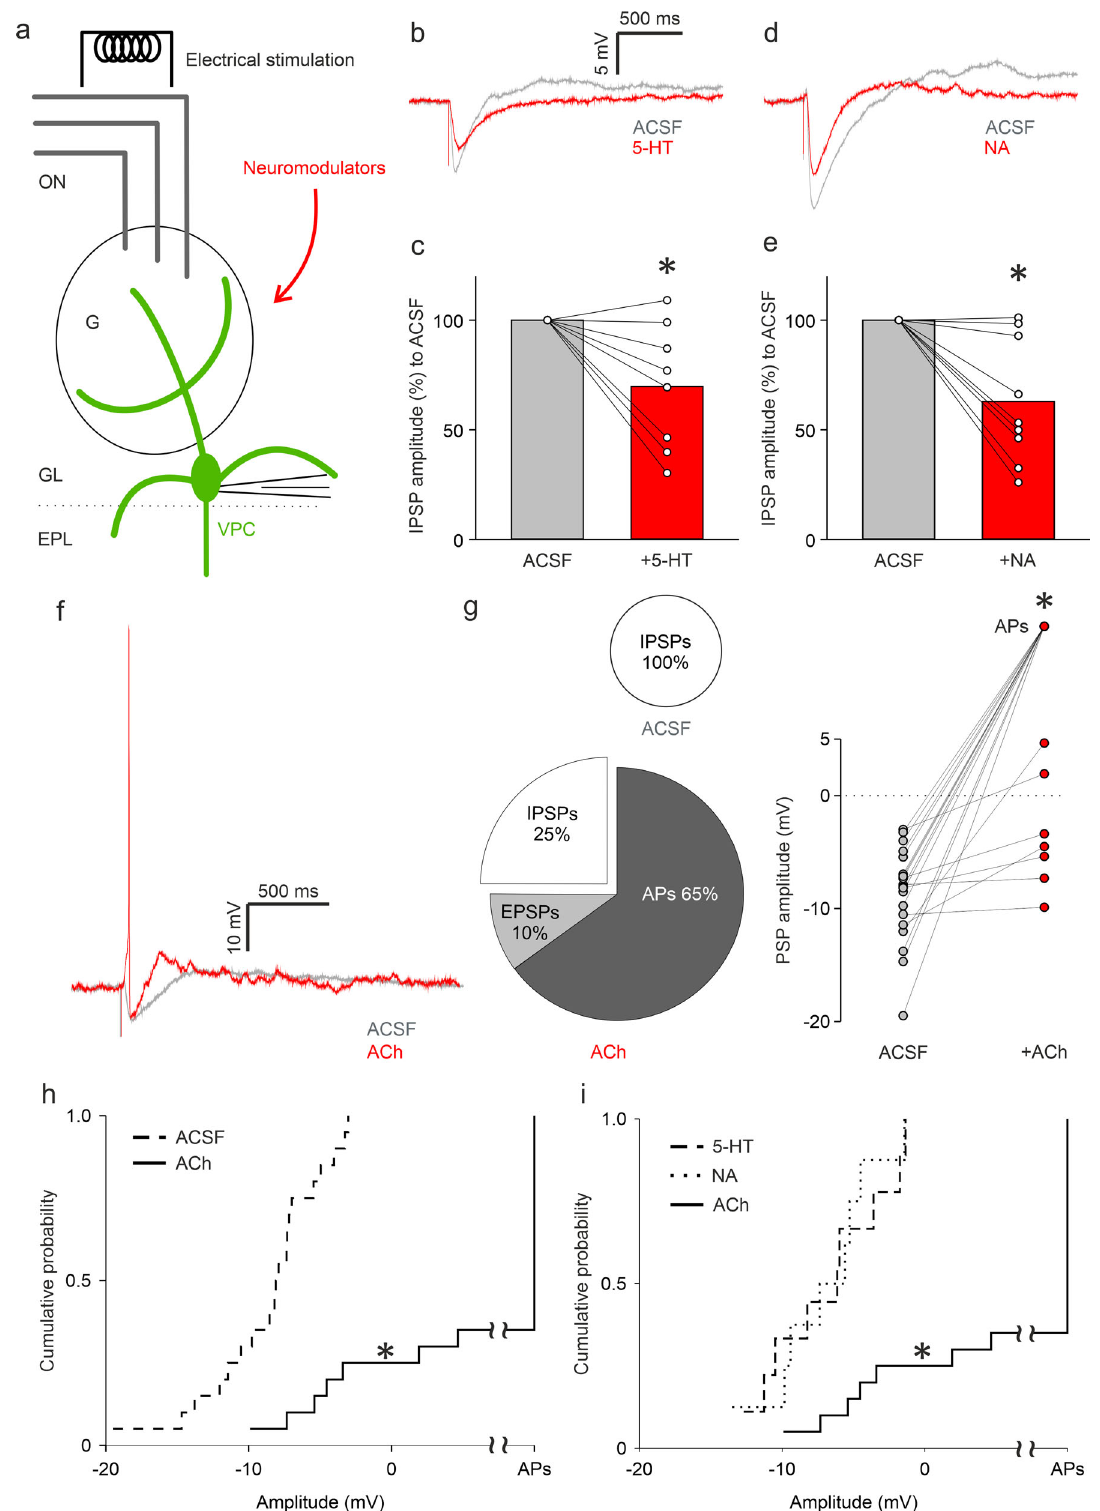
ACh did not alter VPC AP spike frequencies during prolonged somatic current injections (Supplementary Fig. 2a + b; Treatment p = 0.417, Current intensity p < 0.001, Treatment * Current inten- sity p = 0.528, n = 10 from 9 rats) l . Moreover, an increased latency of the fi rst spike was observed for lower current injection levels, indicating rather reduced excitability during ACh treat- ment (Supplementary Fig. 2a + c; Treatment p = 0.080,